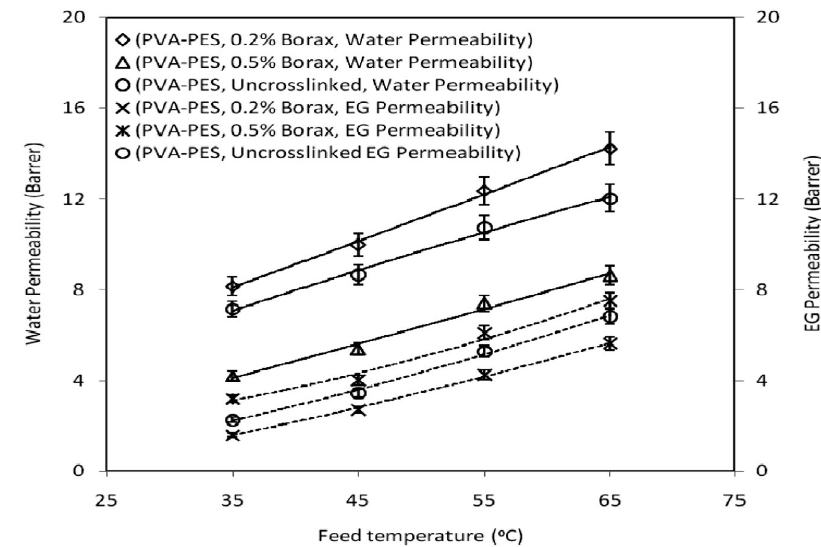
Fig.11. Water and ethylene glycol permeability as a function of feed